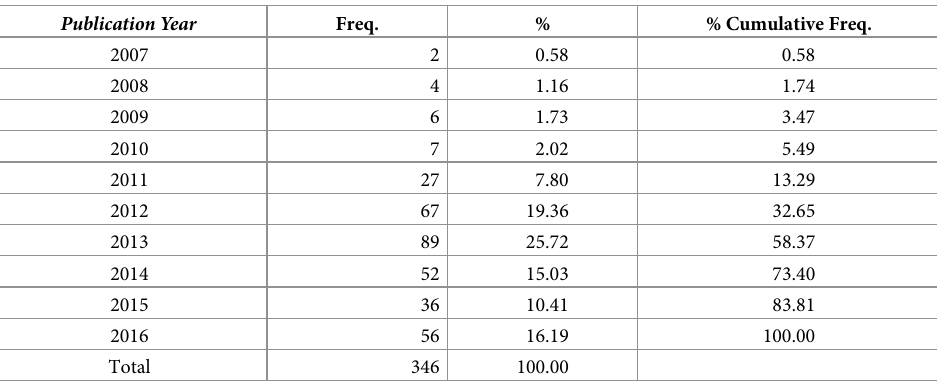
Table 3. Distribution of articles by year of